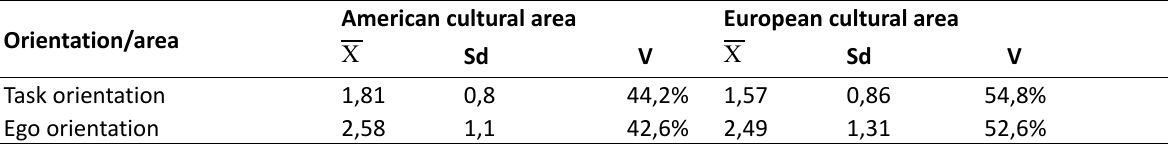
Table 4. Perceptions of success and cultural area